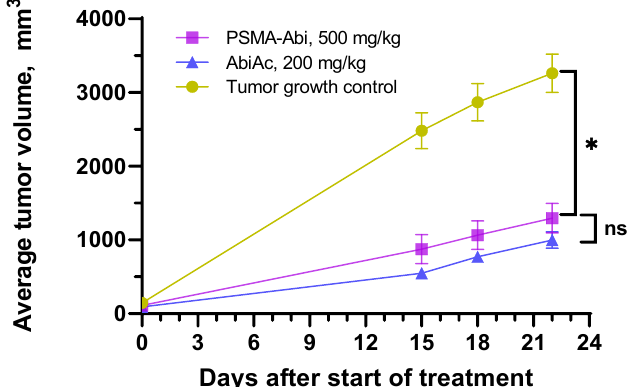
Figure 3. Growth dynamics of subcutaneous 22Rv1 prostate cancer xenografts under the effect of 14-fold oral administration of PSMA-Abi at a single concentration of 500 mg/kg/day (7.0 g/kg total) and AbiAc at 200 mg/kg/day (2.8 g/kg total).